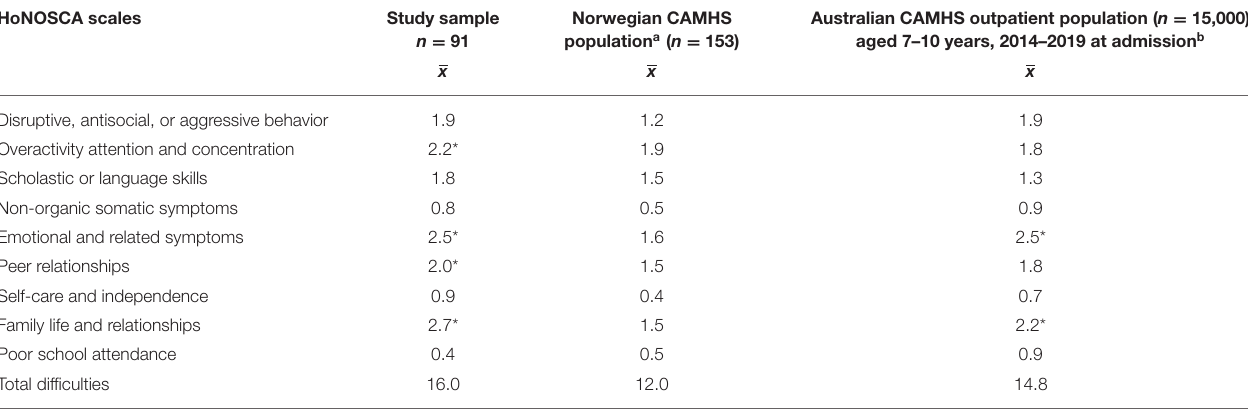
TABLE 1 | Baseline HoNOSCA mean scores ( n = 91).